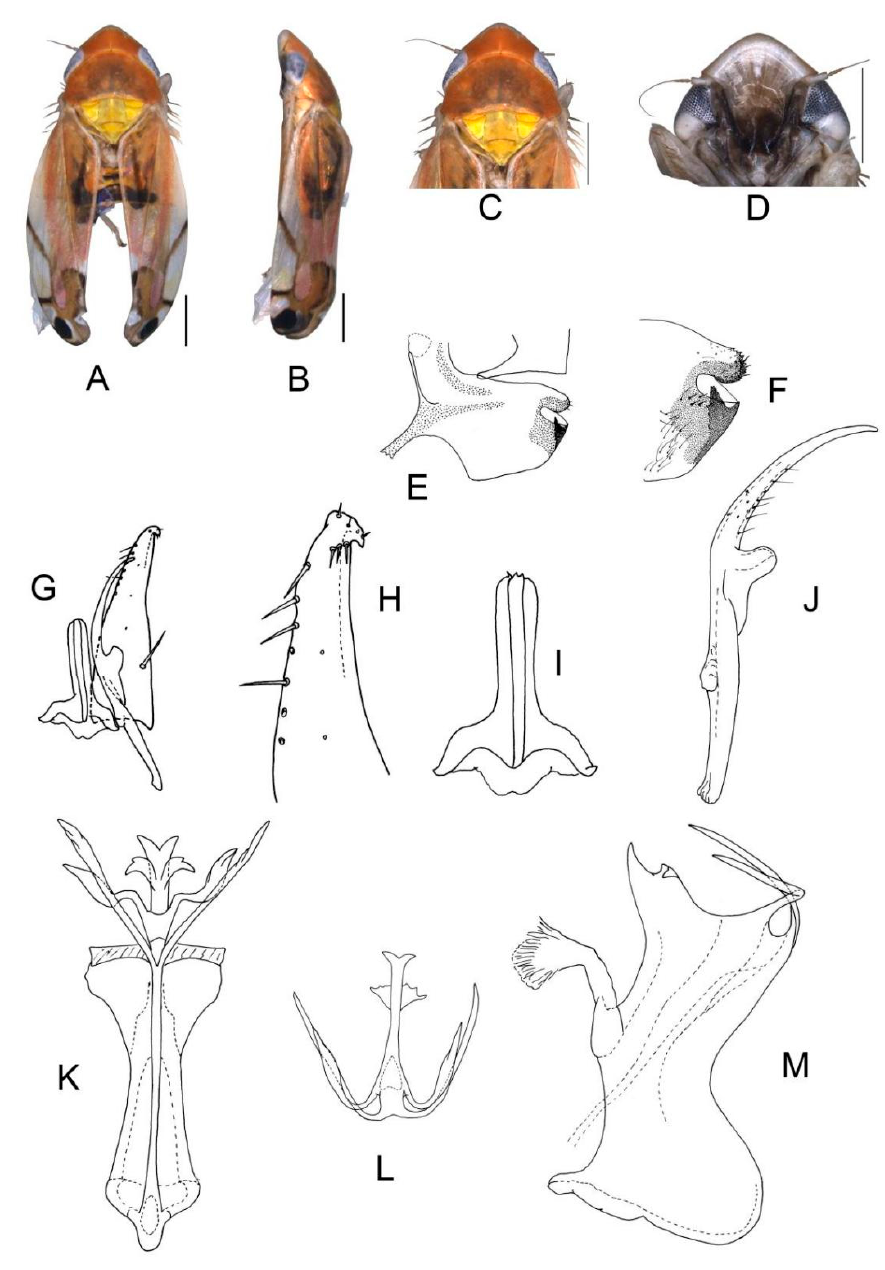
Figure 4. Eurhadina ( Singhardina ) recta sp. nov. : ( A ) habitus, dorsal view; ( B ) habitus, lateral view; ( C ) head and thorax, dorsal view; ( D ) face; ( E ) male pygofer side, lateral view; ( F ) hind part of pygofer, lateral view; ( G ) subgenital plate, connective and paramere, dorsal view; ( H ) apex of subgenital plate, dorsal view; ( I ) connective, dorsal view; ( J ) paramere, dorsal view; ( K ) aedeagus, posterior view; ( L ) apex of aedeagal shaft, dorsal view; and ( M ) aedeagus, lateral view. Scale bars: 0.5 mm. Eurhadina ( Singhardina ) rubra Dworakowska, 1969 (Figure 5A–L) Eurhadina ( Singhardina ) rubra Dworakowska, 1969: 76, Figures 22, 32, 33, 40, 47, 52, 57, 91, 96, 105 [2]; Zhang, 1990: 149, Figure 165 [5]; Dworakowska, 2002: 58, Figures 92– 100 [3].